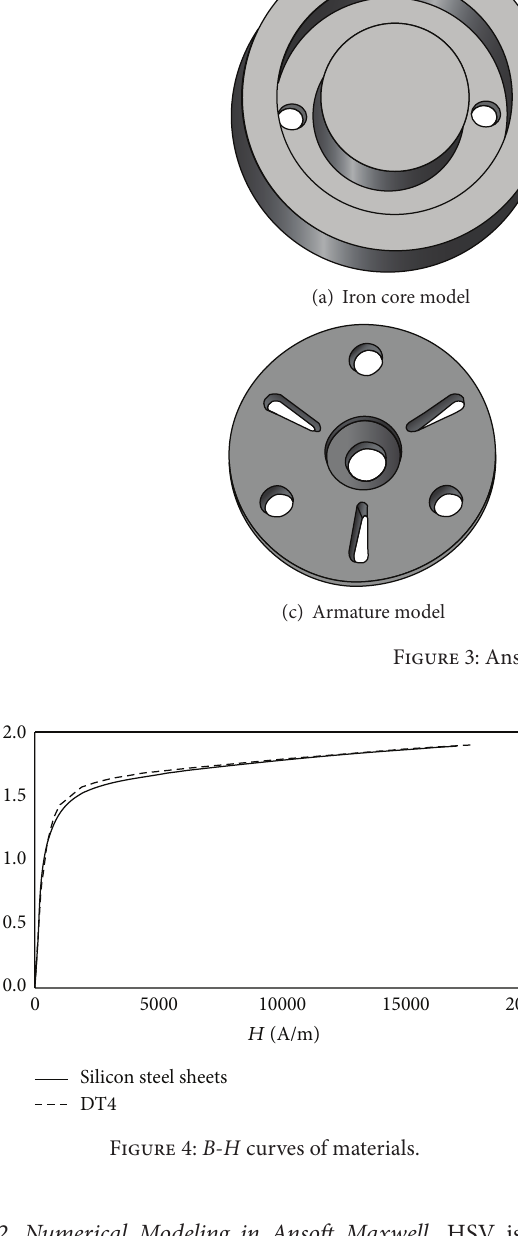
Figure 5: The method of adaptive